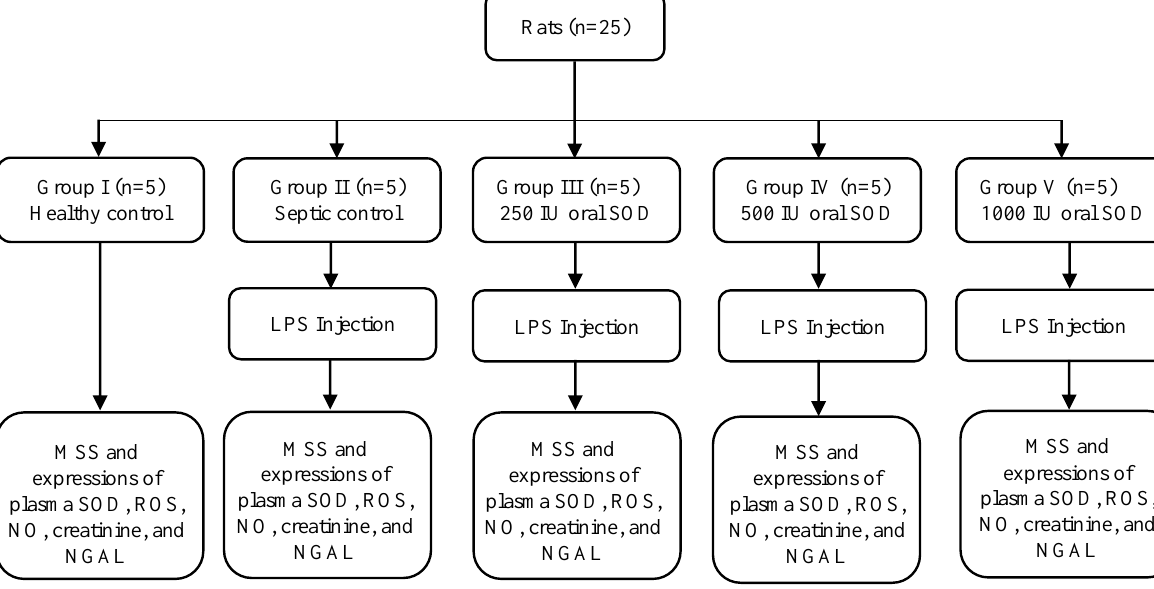
Figure 1. Flowchart of the procedures of study. The rats were equally divided into five groups, where the treated groups received oral SOD daily for 16 weeks. The MSS and expressions of plasma SOD, ROS, NO, creatinine, and NGAL were measured upon pre and 12-hour.